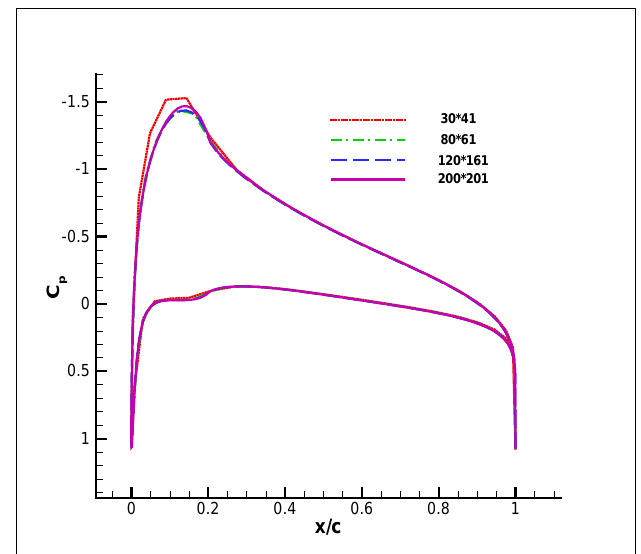
Figure 18. The airfoil surface pressure coefficient distribution using different grid sizes for NACA 2214 airfoil ( M ∞ = 0.55, α = 2 ◦ ). The code FOILcom is used.